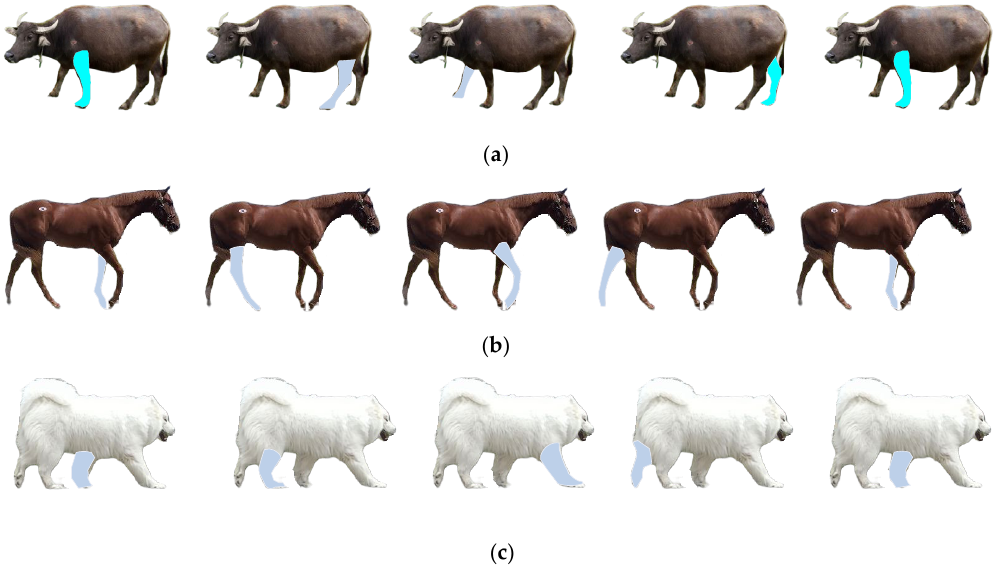
Figure 17. ( a ) Buffalo gait sequence; ( b ) horse gait sequence; ( c ) dog gait sequence. The gait sequence of buffalo, horse, and dog is shown in Table 6. Table 6. Gait sequence of buffalo, horse, and dog.